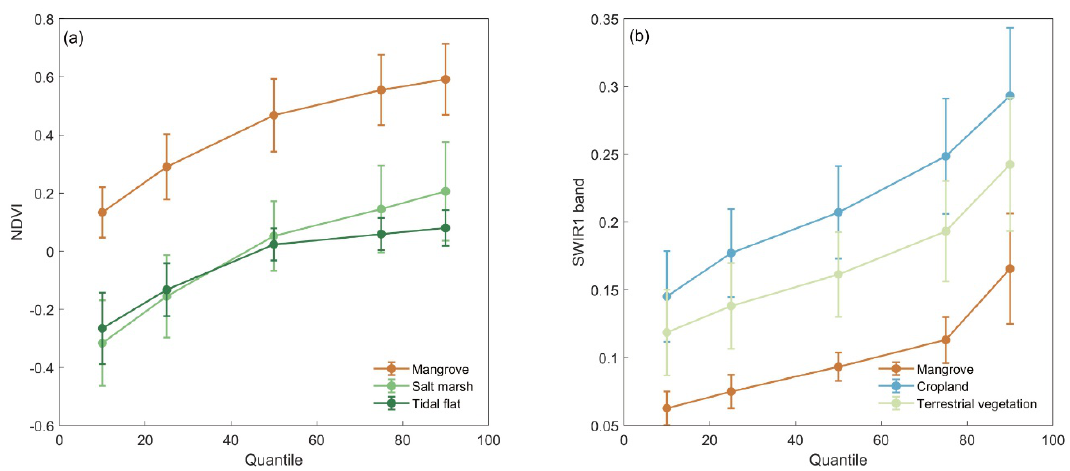
Figure 2. Temporal variability of ( a ) NDVI and the ( b ) SWIR1 band for training pixels of mangroves and other land cover types whose spectral signature is similar to that of mangroves in single-date imagery.